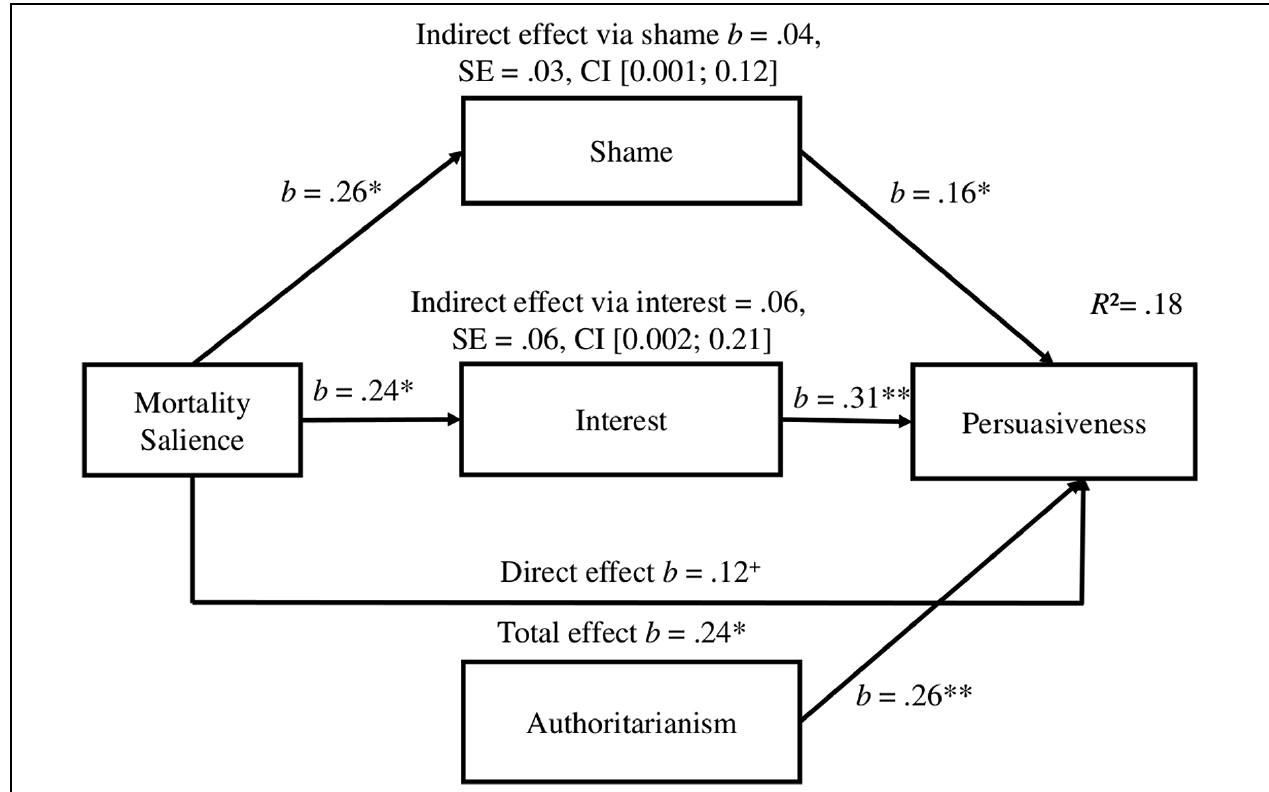
FIGURE 1 | The effect of mortality salience on the perceived persuasiveness of right-wing extremist videos mediated by shame and interest. ∗∗ p > 0.01, ∗ p > 0.05, + p > 0.10. Parameter estimates are based on 1000 bootstrap